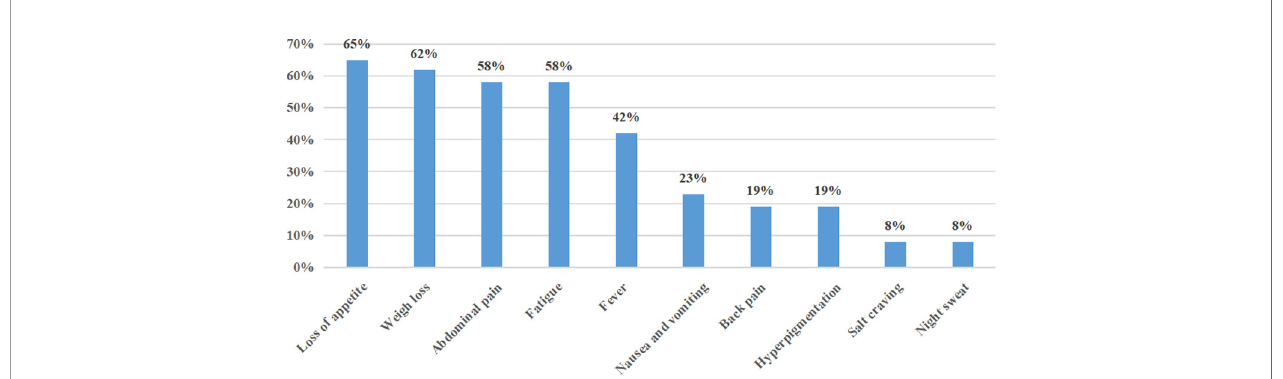
FIGURE 2 | Frequency of clinical presentations of PAL in this